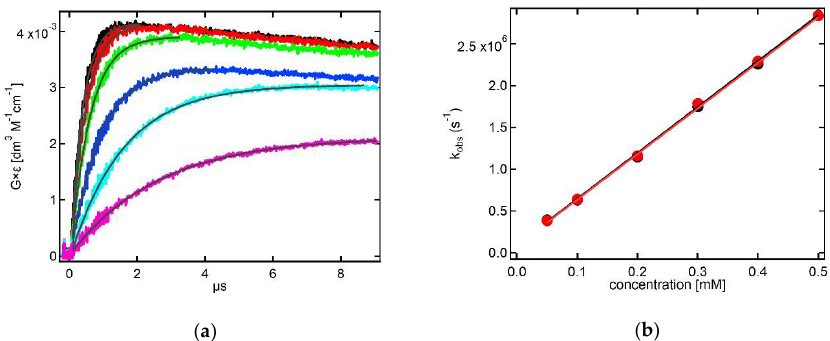
Figure 8. ( a ) Time profiles representing growth of transient absorptions at λ = 430 nm recorded after the electron pulse in N 2 O-saturated aqueous solutions at pH = 11.3 containing 0.1 M NaN 3 and various concentrations of 7-OCH 3 -3-MeQ: ( ▬ ) 0.05 mM, ( ▬ ) 0.1 mM, ( ▬ ) 0.2 mM, ( ▬ ) 0.3 mM, ( ▬ ) 0.4 mM and ( ▬ ) 0.5 mM ( b ) Plots of the observed pseudo-first-order rate constants of the formation of the 430-nm absorption (●) and the 530-nm absorption (●) as a function of 7-OCH 3 -3-MeQ concentration in N 2 O-saturated aqueous solutions at pH = 11.3 containing 0.1 M NaN 3 .